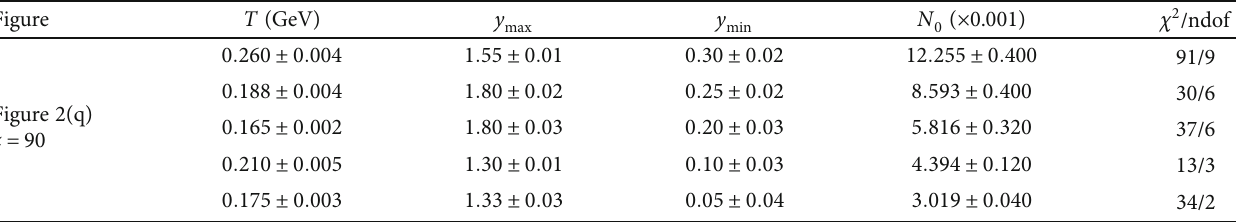
Figure 2(q) z = 90